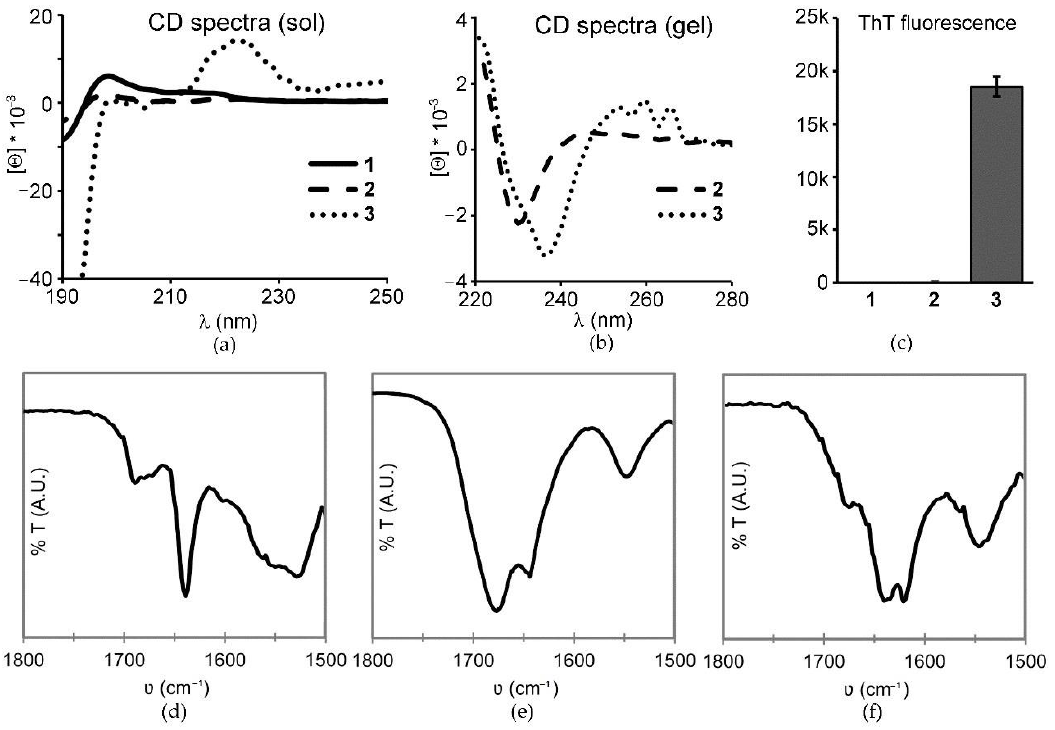
Figure 4. Circular dichroism (CD) spectra in the sol ( a ) and gel ( b ) states; ( c ) thioflavin T fluorescence; ( d – f ) Fourier-transform infrared (FT-IR) spectra of compounds 1 ( d ), 2 ( e ), and 3 ( f ) in the gel state.